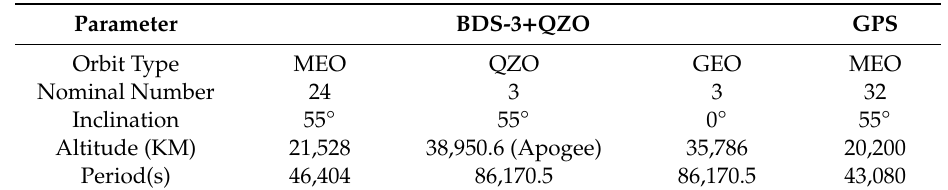
Table 1. Constellation parameters of third-generation BeiDou navigation satellite system (BDS-3) + Quasi-Zenith orbit (QZO) and Global Positioning System (GPS)